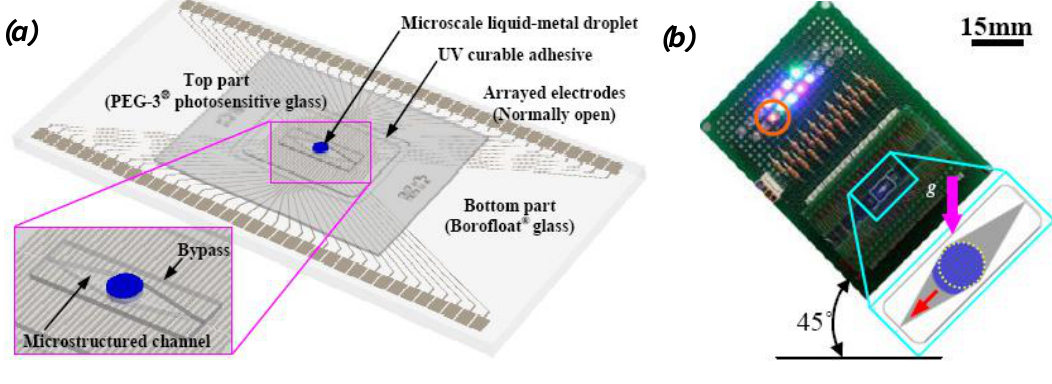
Figure 11. Liquid-metal droplet based accelerometer. (a) the schematic view; and (b) a prototype tilted at